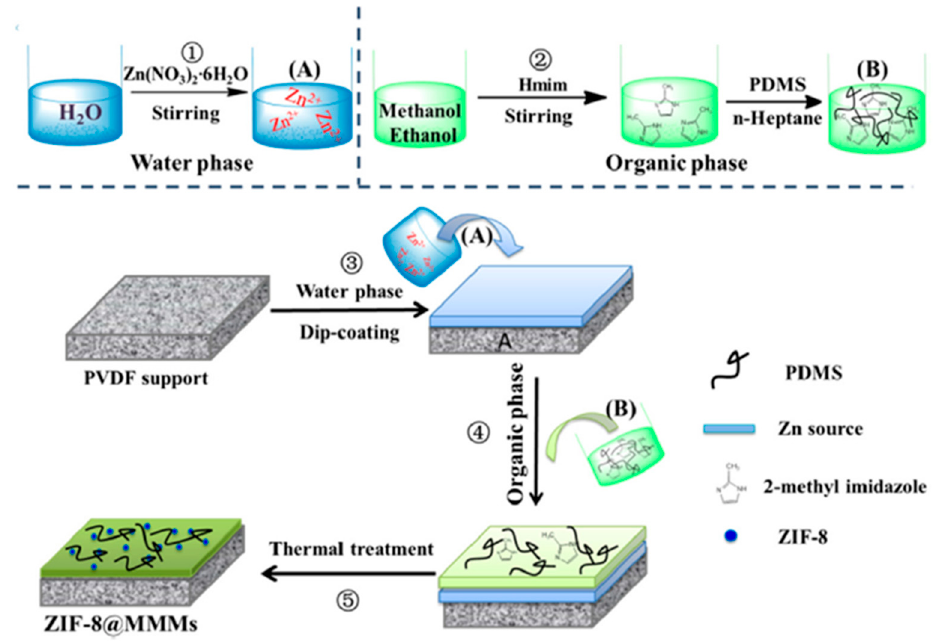
Figure 3. In situ fabrication procedure of the ZIF-8-MMM [98].